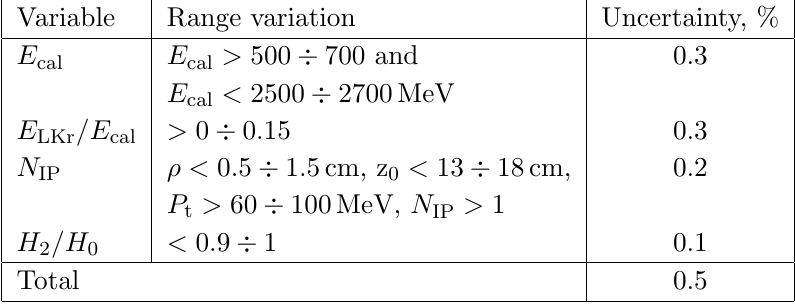
Table 7 . (cid:0) ee ( J= ) (cid:1) B hadrons ( J= ) uncertainty in % due to variation of the selection criteria for hadronic